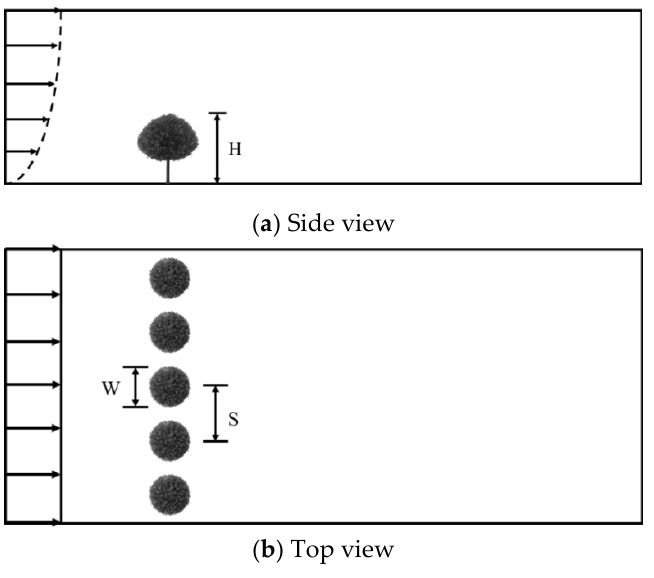
Figure 2. Schematic of the study.